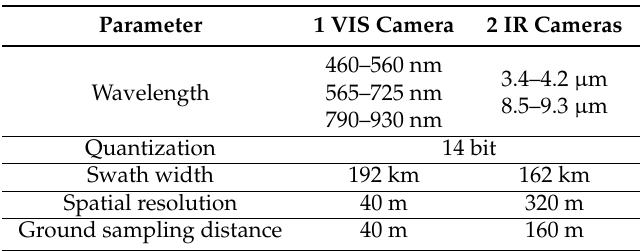
Table 1. Main characteristics of TET-1 instruments